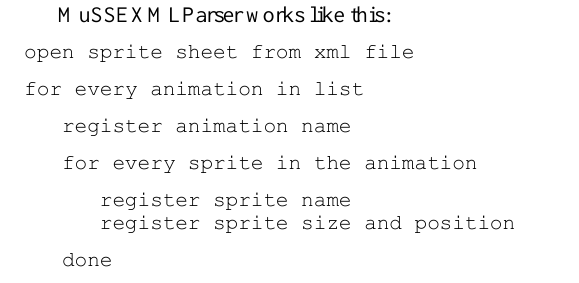
Fig. 21. Example from Figure 19 using correct threshold. Source: MuSSE with sprite sheet image from the game Ragnarok Online©.